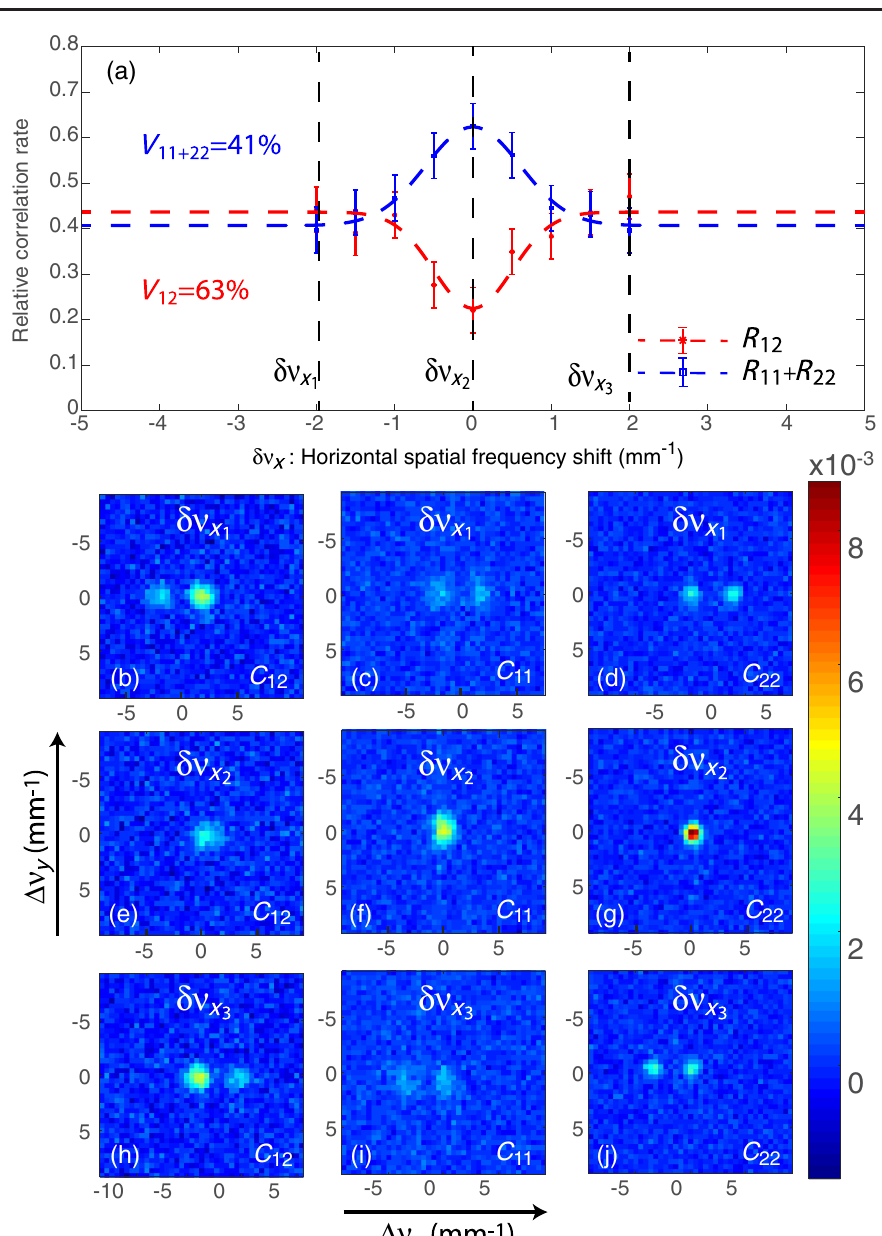
FIG. 7. (a) Relative correlation ratios as a function of the horizontal spatial frequency shift δν x . (b) – (j) Average normalized spatial- momentum correlation distributions C 12 , C 11 , and C 22 for different values of the horizontal